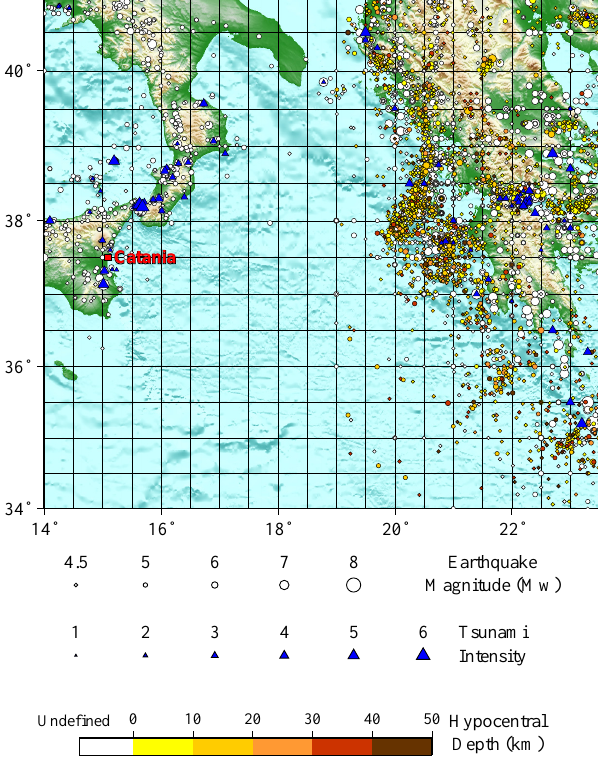
Fig. 1. Sketch of the region of interest. Earthquakes (circles) and tsunami events (triangles) of the Ionian sea are plotted together. Earthquakes are classified for class of magnitude (size of the cir- cle) greater than 4.5 and for hypocentral depth (colour scale). The seismic dataset has been compiled putting together three catalogues (CPTI Working Group, 2004; Papaioannou et al., 2000; Papazachos et al., 2007). Tsunamis and their intensities (size of the triangle) are drawn after Tinti et al.